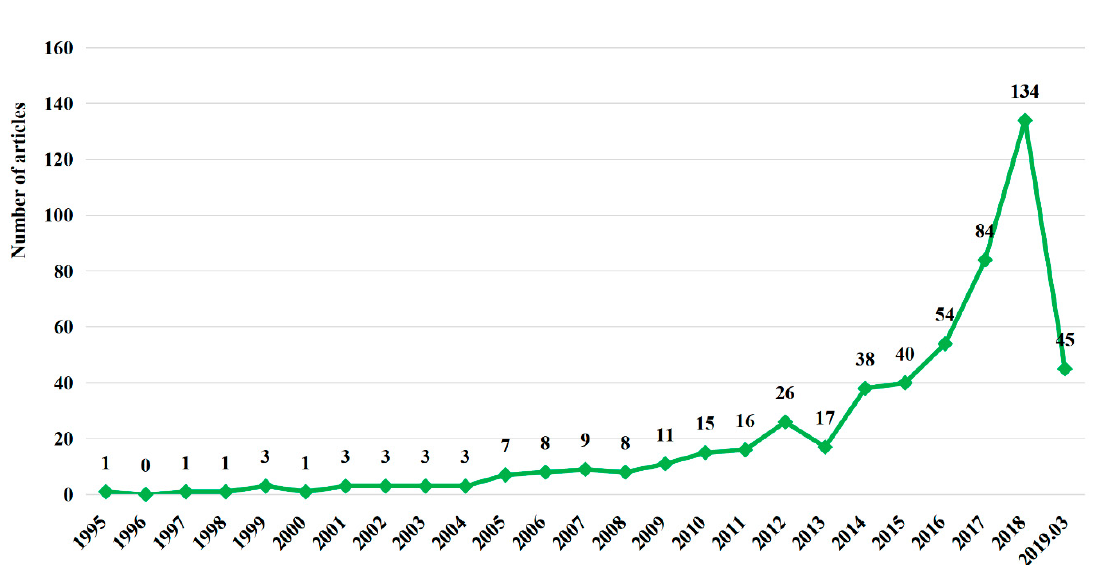
Figure 3. Literature statistics for the theory of planned behavior (TPB) as applied to environmental science.